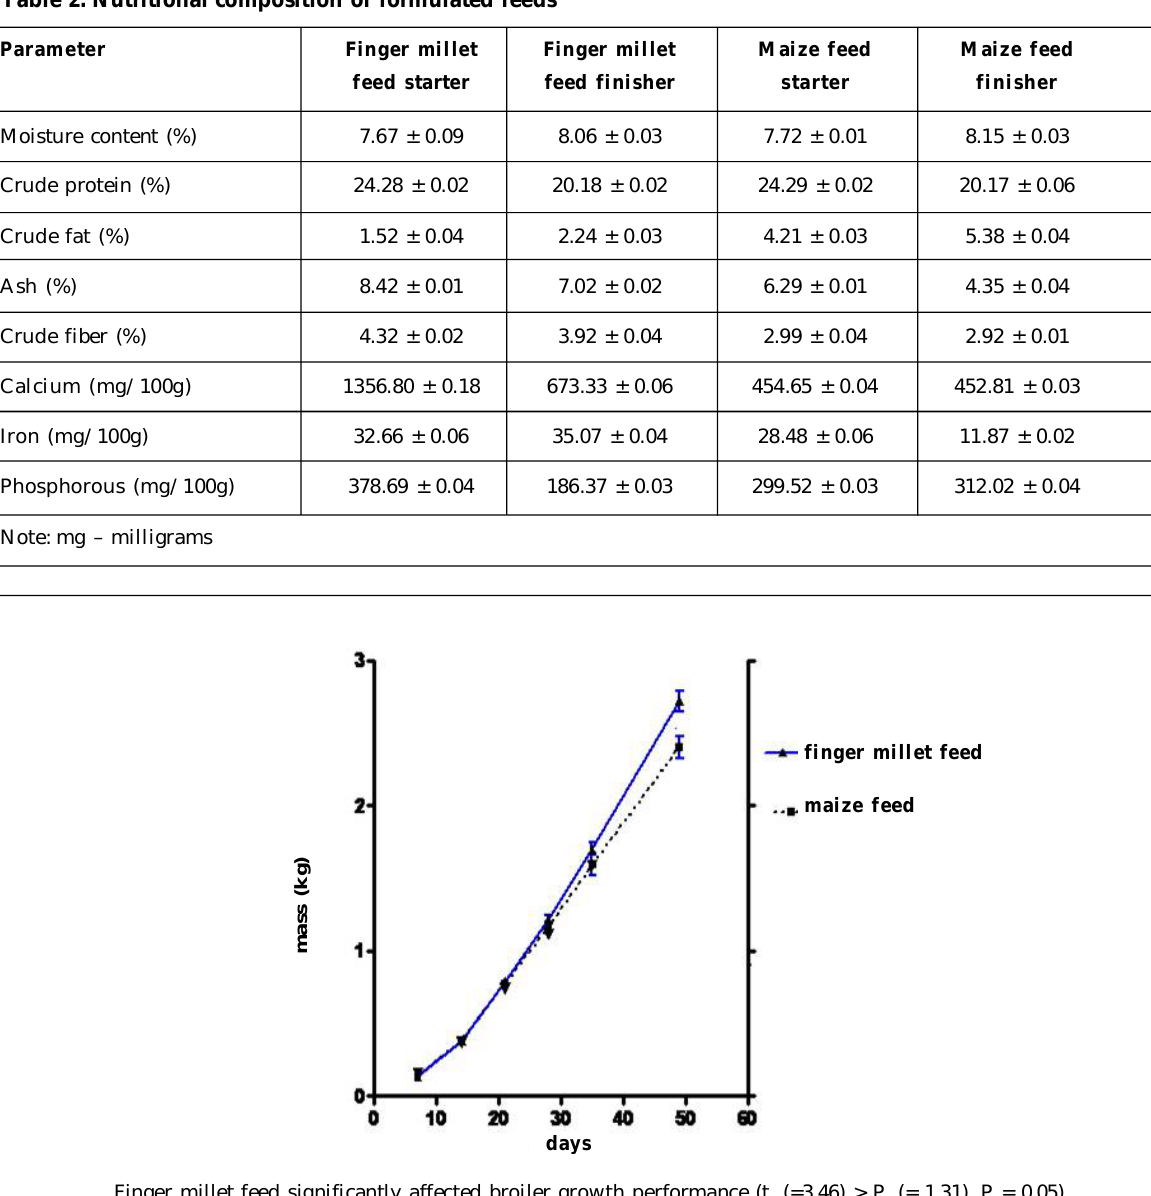
Table 2: Nutritional composition of formulated feeds